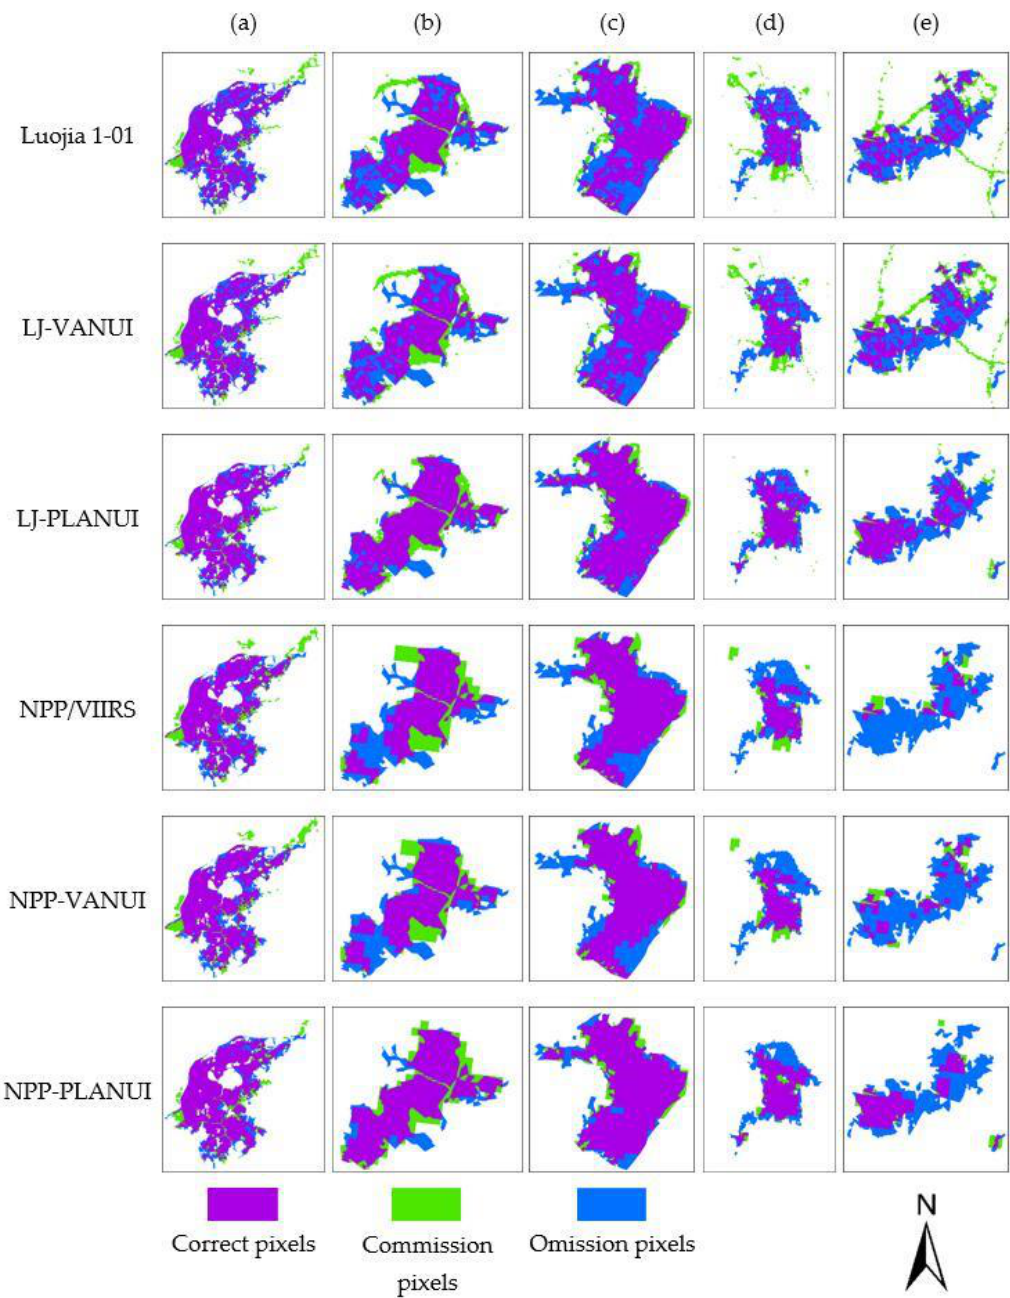
Figure 7. Error analysis for the extraction results from NTL, VANUI, and PLANUI in the selected regions in Nanjing: ( a ) Main Urban Area; ( b ) Liuhe; ( c ) Pukou; ( d ) Lishui; ( e ) Gaochun.